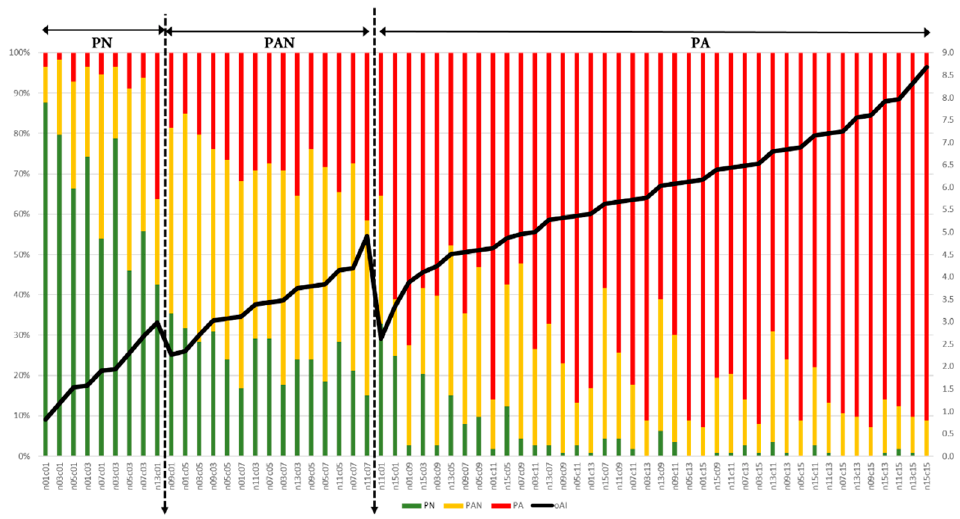
Figure 3. oAI vs. asymmetry classification.